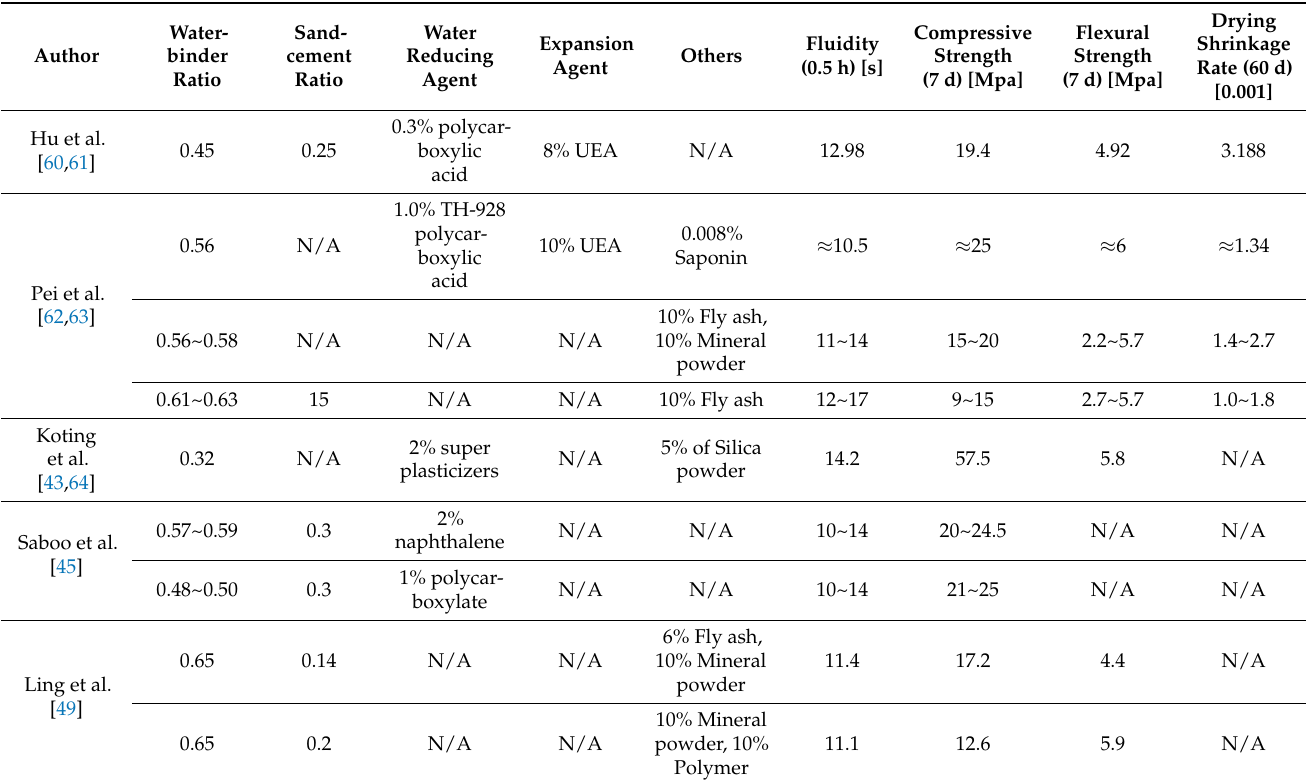
Table 7. Formulas of raw materials and performance of